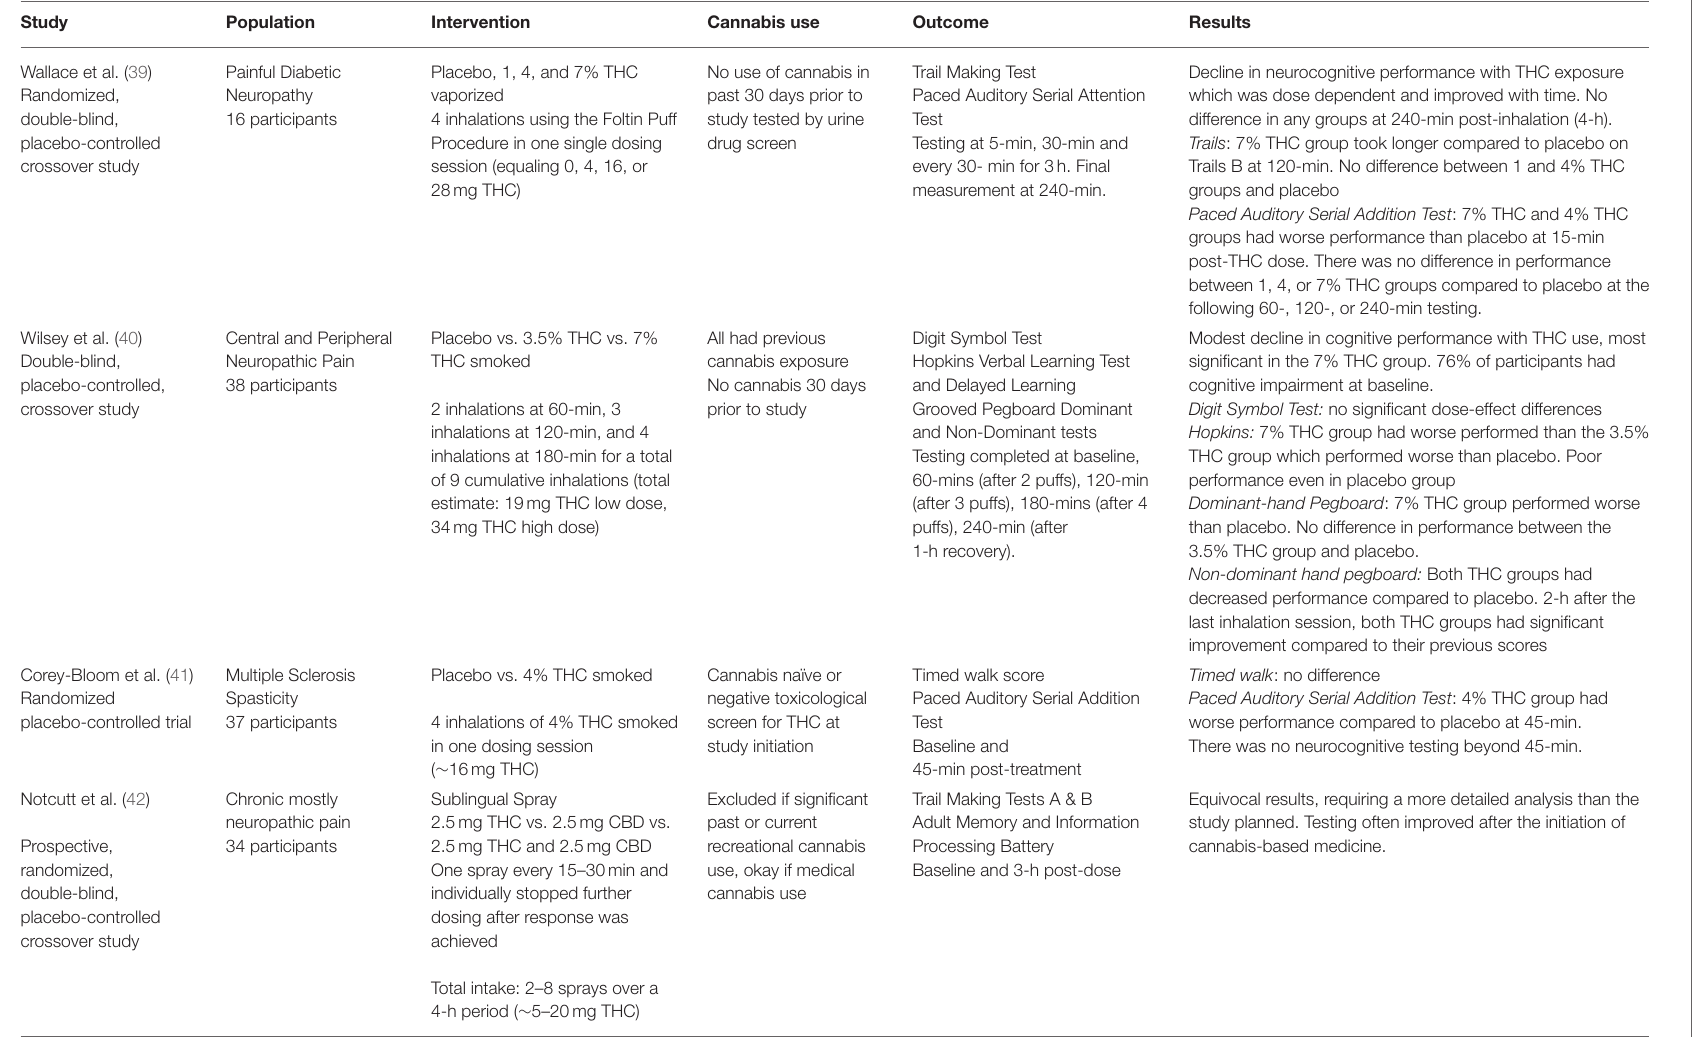
TABLE 3 | Study characteristics and